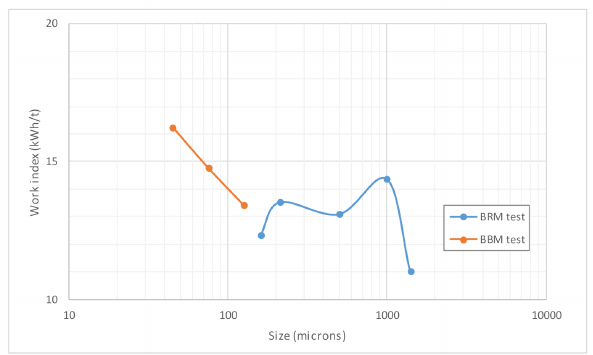
Figure 7. Variation of BBM and BRM gpr values with P 100 , Mittersill ore.